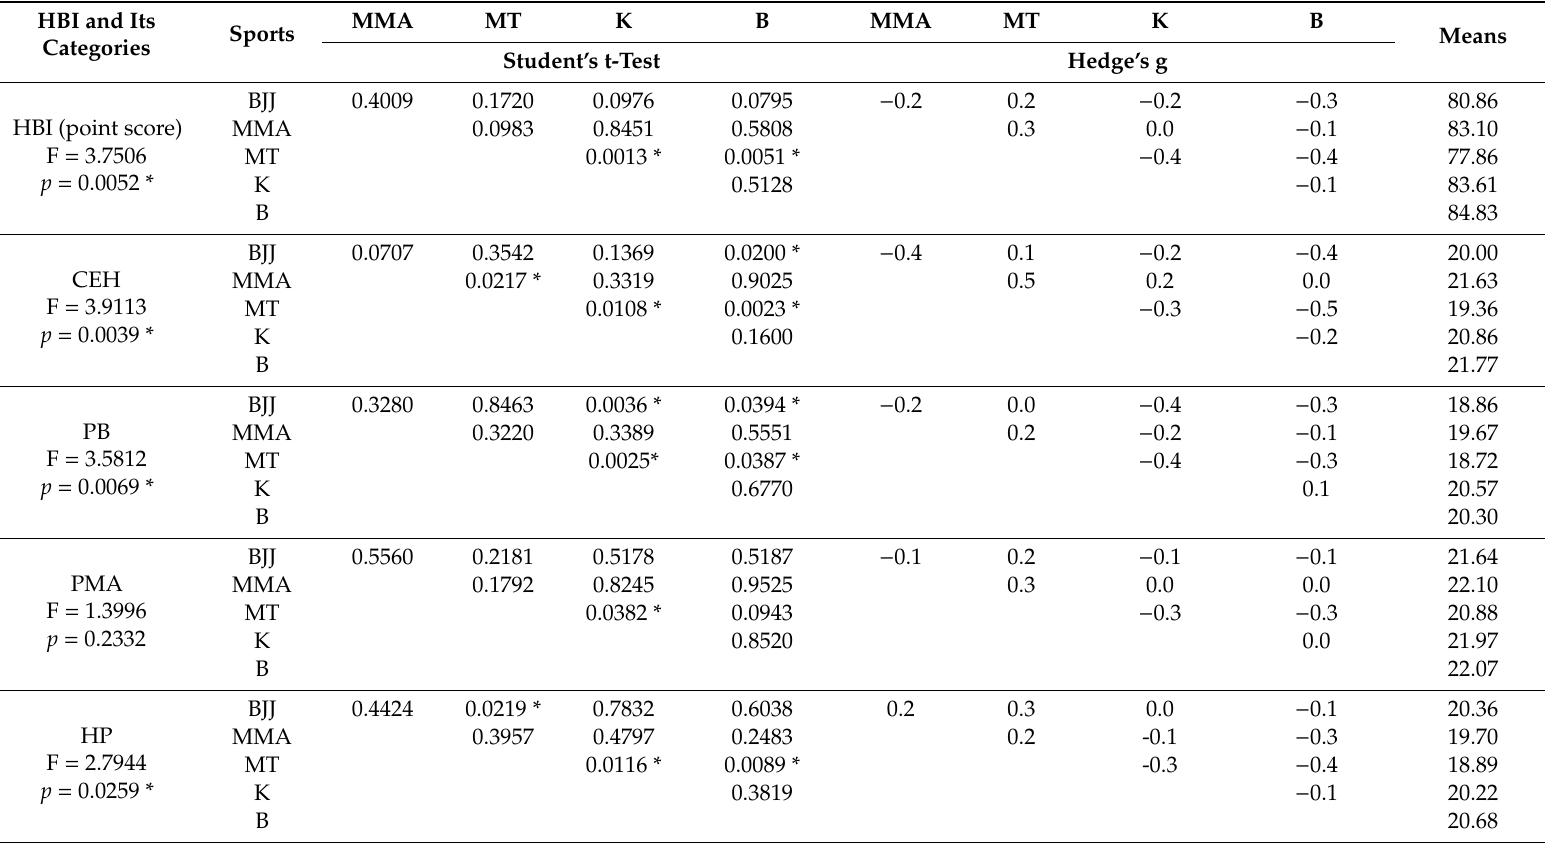
Table 2. Health behaviors of people who practice CS and MS (F-test, Student’s t-test, Hedge’s